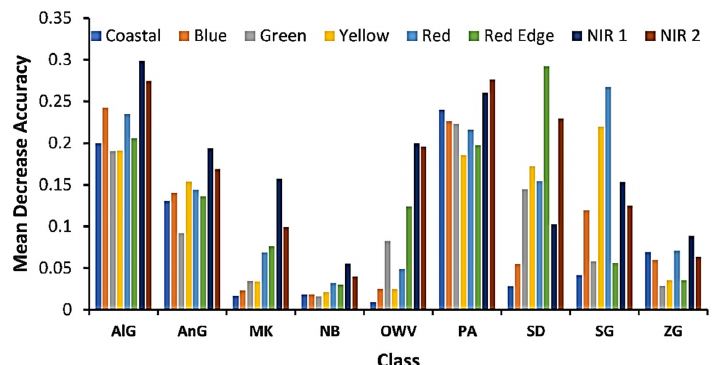
Figure 7. The mean decrease accuracy (MDA) values show the relationship between each tree species and WorldView-2 spectral bands as measured by the RF classifier. Full species names for each species code are given in Table 1.